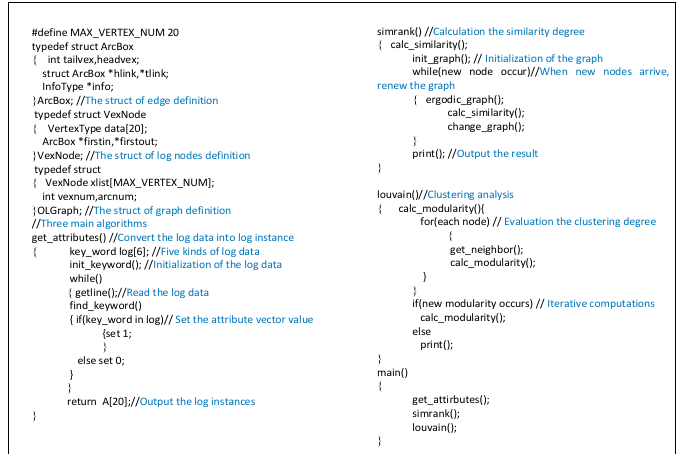
Figure 9. The pseudo-code of Log Instance Correlation Module (LICM) module.